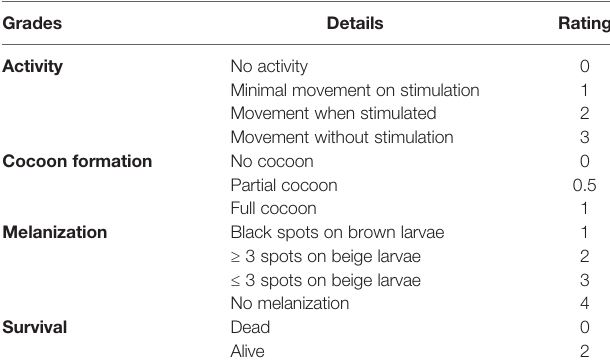
TABLE 4 | Health index score system of G. mellonella larvae (adapted from Loh et al., 2013).